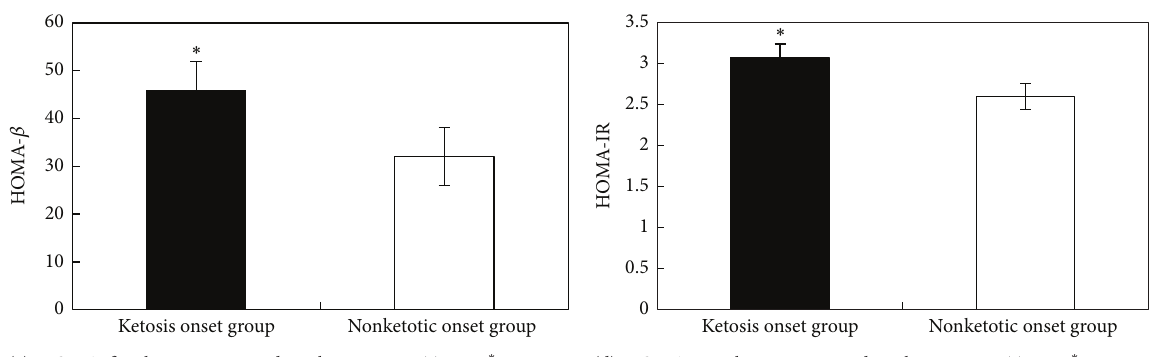
Figure 1: Comparisons of islet 𝛽 -cell function and insulin resistance between two